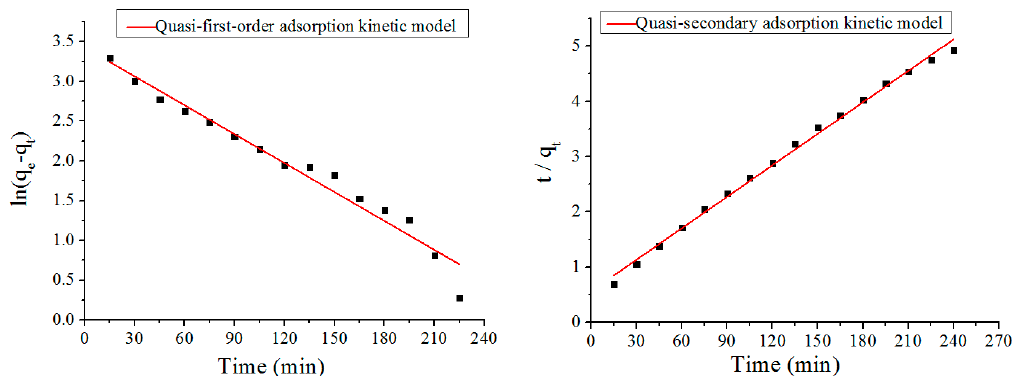
Figure 10. Fitting diagram of quasi-first-order adsorption kinetics model ( left ) and quasi-secondary adsorption kinetics model ( right ). Table 3. Results of CS/GO aerogel adsorption kinetics model fitting. Model